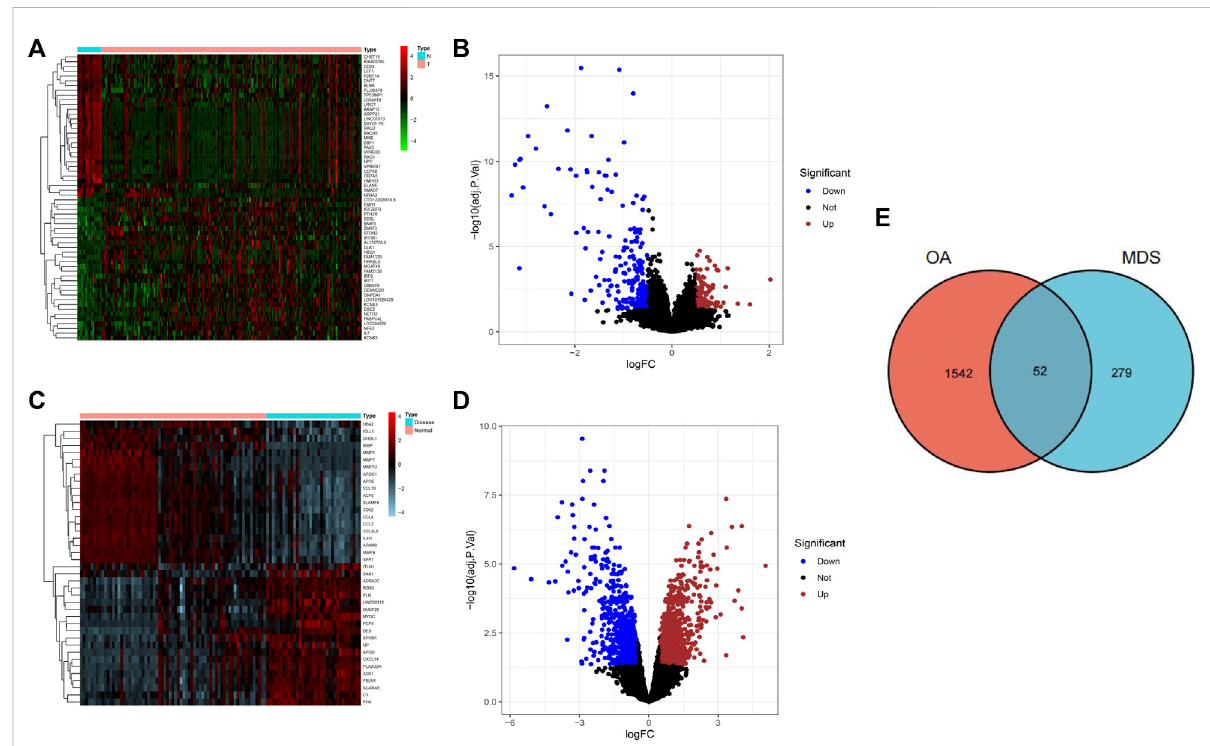
FIGURE 1 ScreeningresultsofDGEsforosteoarthritisandmyelodysplasticsyndromes. (A) Heatmapshowingthetop50OA-associatedDEGs. (B) Volcano plot showing 331 OA-associated DEGs. (C) Heatmap showing the top 50 MDS-associated DEGs (D) Volcano plot showing 331 osteoarthritis- associated DEGs. (E) Wayne diagram indicating common disease